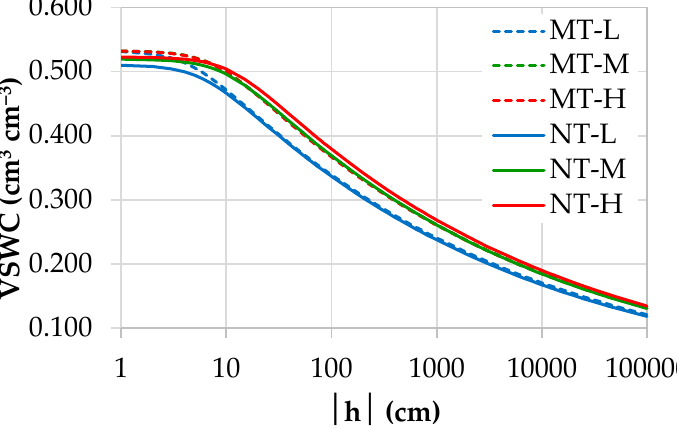
Figure 4. Mean values of volumetric soil water content, VSWC, vs. absolute value of soil pressure head, h , obtained with BEST-steady for low (L), intermediate (M) and high (H) infiltration runs, under minimum tillage (MT) and no-tillage (NT). Table 1. Statistics of soil water retention curve parameters, i.e., saturated soil water content, θ s , n , m and scale parameter, h g , obtained with BEST-steady, under different water pouring heights and soil management practices. L H Parameter